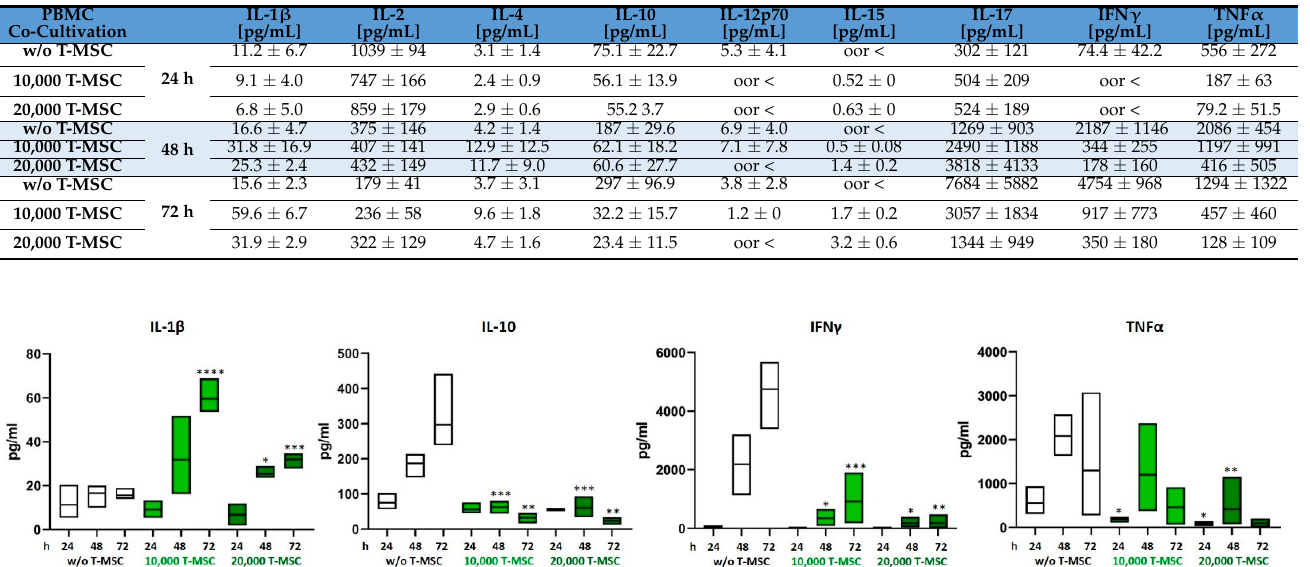
Table 1. Co-cultivation of PBMC with T-MSC results in an altered cytokine profile. PBMC were stimulated with IL-2/OKT3 and co-cultivated with T-MSC. Supernatants of co-cultures were analyzed after 24, 48, and 72 h. The cytokine levels were determined by Multiplex analyses. Data show mean ± SD, n = 4; oor <: out of range below detection level (detection levels according to standard curves for each cytokine listed in methods Section 2.3). PBMC: peripheral blood mononuclear cell; T-MSC: tumor-derived mesenchymal stromal cell; IL: interleukin; IFN γ : interferon gamma; TNF α : tumor necrosis factor alpha.